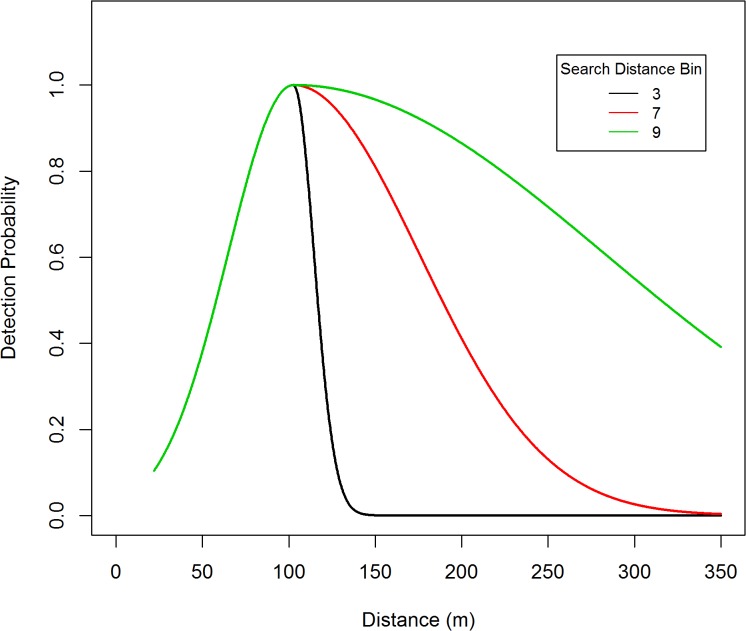
The effect of binned search distance on average covariate detection of black bears in the Skwetna study area of South-Central Alaska.